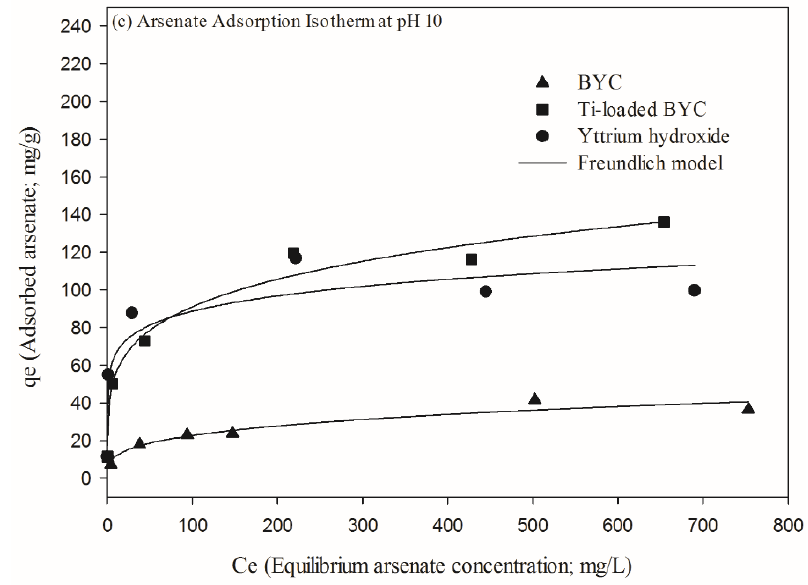
Figure 7. Adsorption isotherm at pH 4( a ), pH 7( b ) and pH 10( c ) by the adsorbents (dose: 1g/L, Temperature: 298K, reaction time: